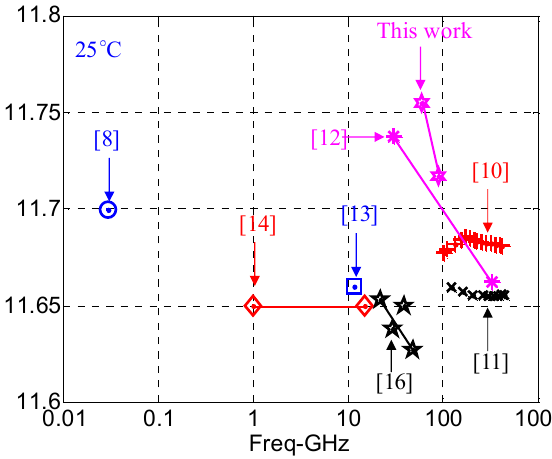
Figure 10. A comparison of the measured permittivity of silicon at different frequency ranges.